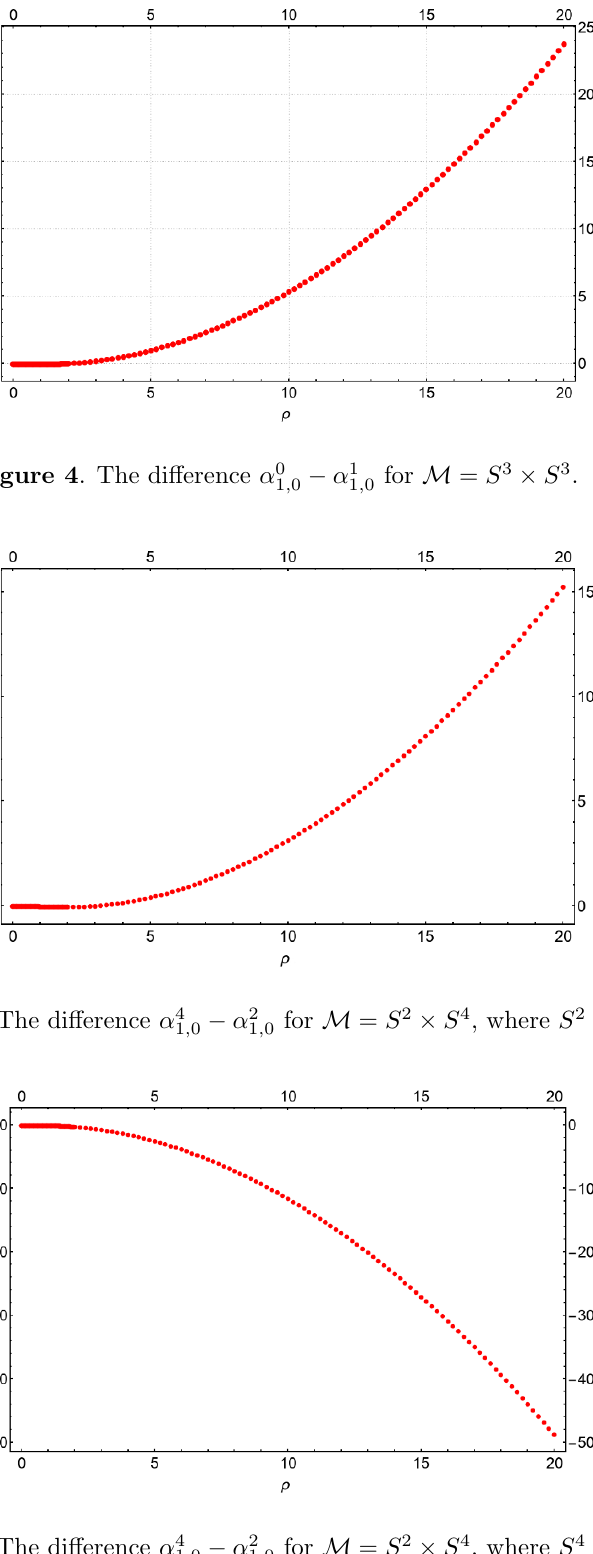
Figure 6 . The di(cid:11)erence (cid:11) 4